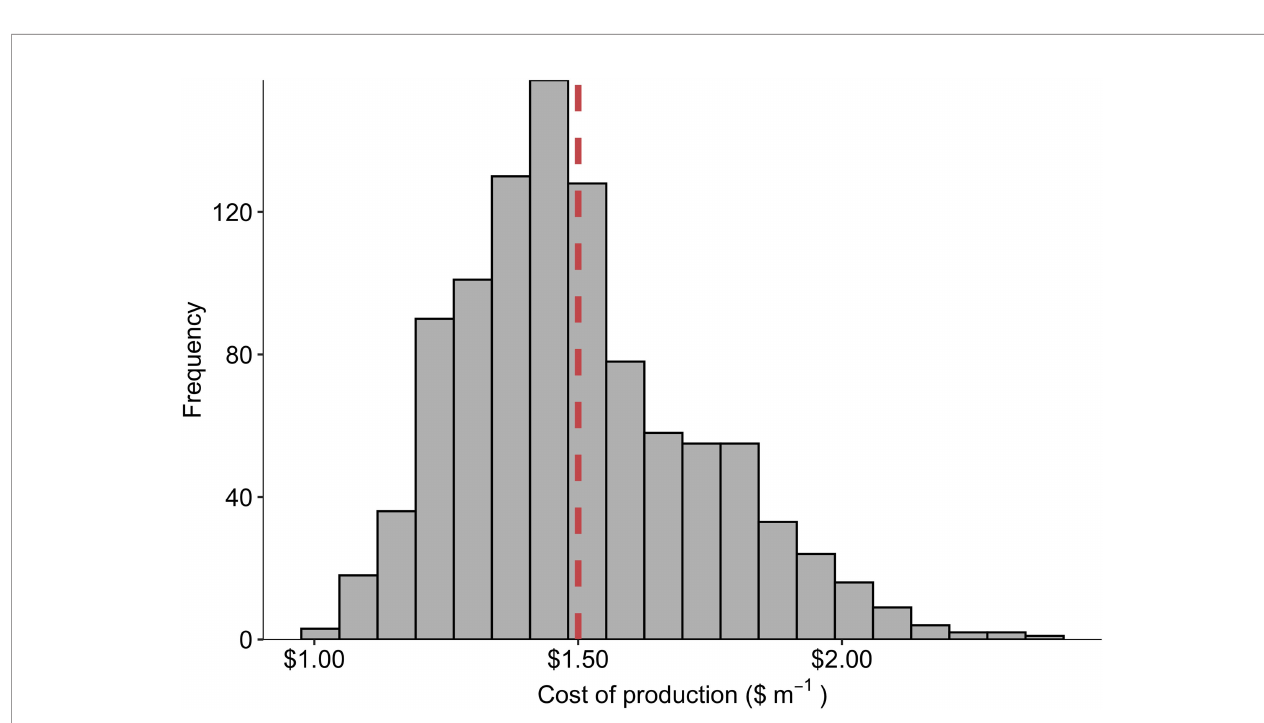
FIGURE 5 | Frequency histogram of production costs ($ m -1 ) derived from 1,000 iterations of a Monte Carlo simulation in which the grow-out duration (days), labor requirements (m of twine per FTE employee), energy costs ($ kWh -1 ), and facility construction costs ($ m -2 ) were simultaneously modeled as potentially random variables with triangular probability distributions. The dashed vertical line depicts the average (n = 1,000) cost of production value over all simulations: $1.50 m -1